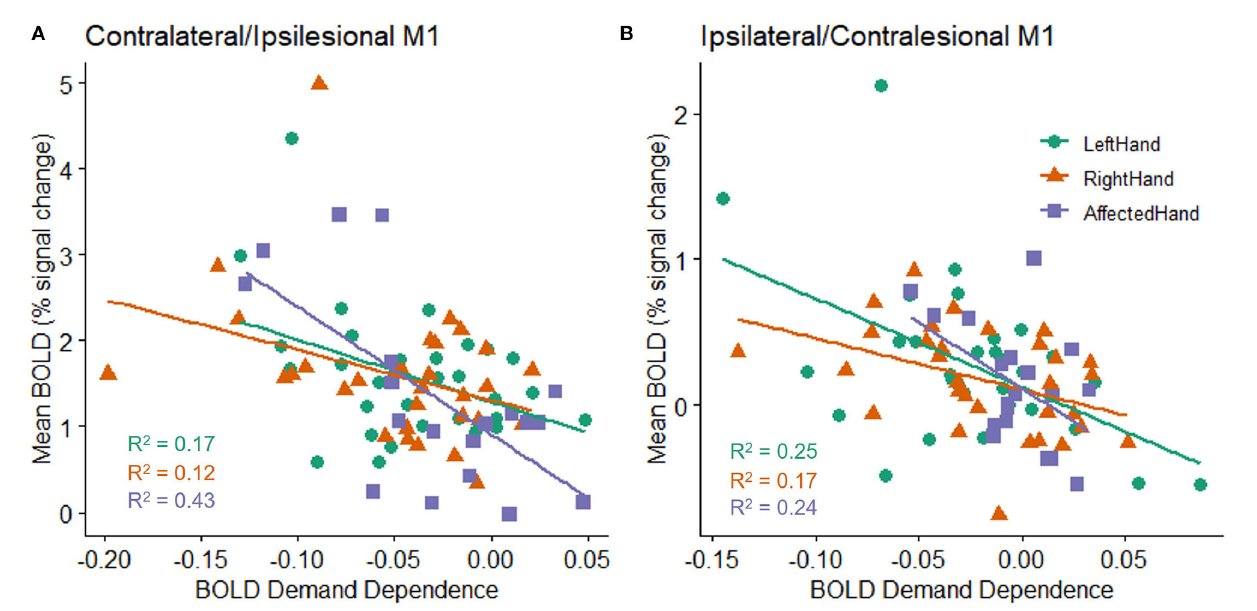
FIGURE 4 | Relationship between an individual’s mean BOLD response (percent signal change) across all target sizes and the slope fit to an individual’s BOLD response (BOLD demand dependence) during movement to each of the four different target sizes in the (A) contralateral (healthy subjects) or ipsilesional (patients with stroke) M1 ROI, and (B) ipsilateral (healthy controls) or contralesional (patients with stroke) M1 ROI. All groups show a statistically reliable correlation between BOLD activity and BOLD demand dependence, with higher mean BOLD activation related to a steeper slope in M1 activation changes (i.e., a larger decrease in activation for the largest targets relative to the smallest targets). A negative demand dependence slope indicates less activation for large targets than small